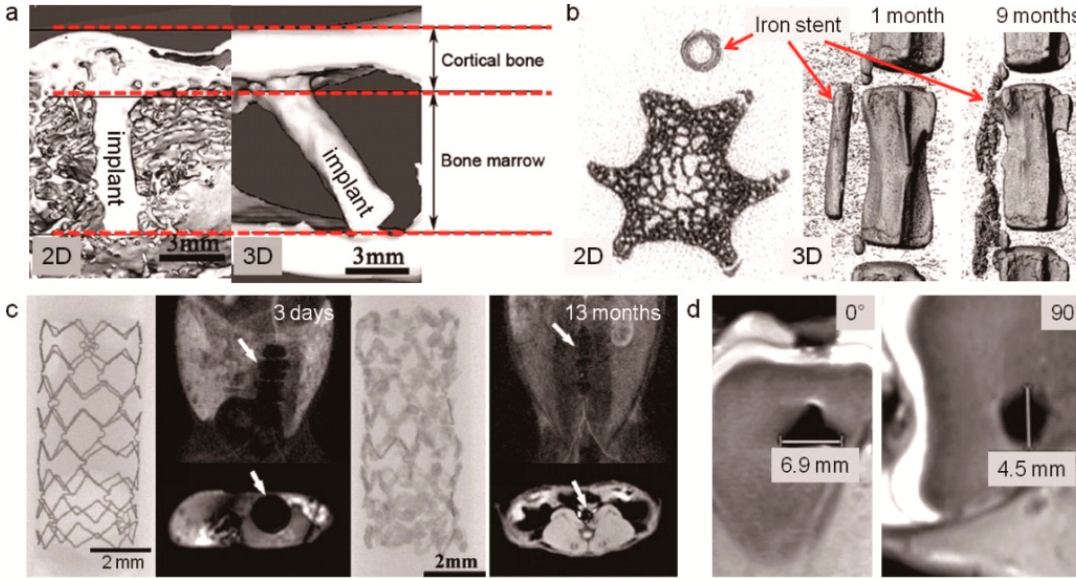
Figure 5. Tissue-implant interaction assessment: ( a ) Micro-Computed Tomography (µCT) image of a high-purity Mg pin implanted in the femur of New Zealand white rabbits after 16 weeks enabling the visualization of implant morphological change both on the surface and the internal architecture and reaction of the attached hard tissue; ( b ) µCT image of pure Fe stent after 1 and 9 months implanted in tail veins of mice allowing a follow-up of detail morphological change of the stent during the corrosion process; ( c ) Magnetic Resonance Imaging (MRI) image of Fe stent after 3 days and 13 months implantation in the abdominal aorta of rabbit showing the detail structural change of the stent; ( d ) MRI image of Mg Herbert screw in chicken femoral bone showing a lesser artifact produced by absorbable metal implant than by inert implant. Adapted with permission from Elsevier and John Wiley and Sons [22,58,63,65].